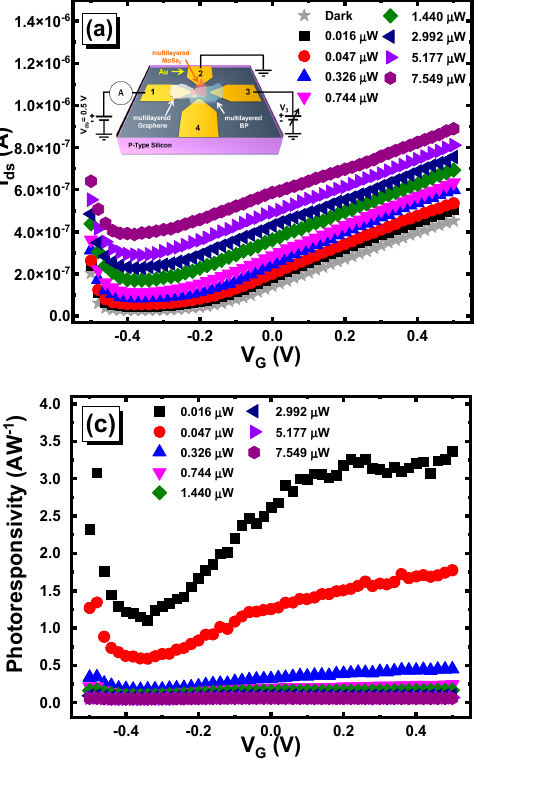
Figure 7. Gate voltage and laser power dependence in Gr/n-MoSe 2 heterojunction: ( a ) Transfer characteristic I ds –V G (or I 12 –V 3 ), ( b ) photocurrent, ( c ) photoresponsivity, and ( d ) specific detectivity at drain–source voltage (V ds or V 12 ) of 0.5 V.